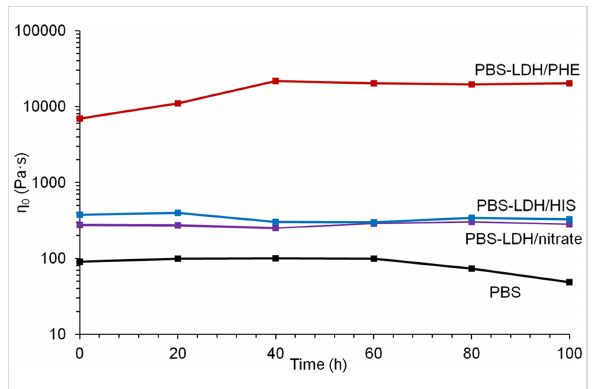
Figure 9: Evolution of zero-shear viscosity (in logarithmic scale) vs time for PBS and PBS nanocomposites with Mg 2 Al LDH during photo- degradation tests at 60 °C.